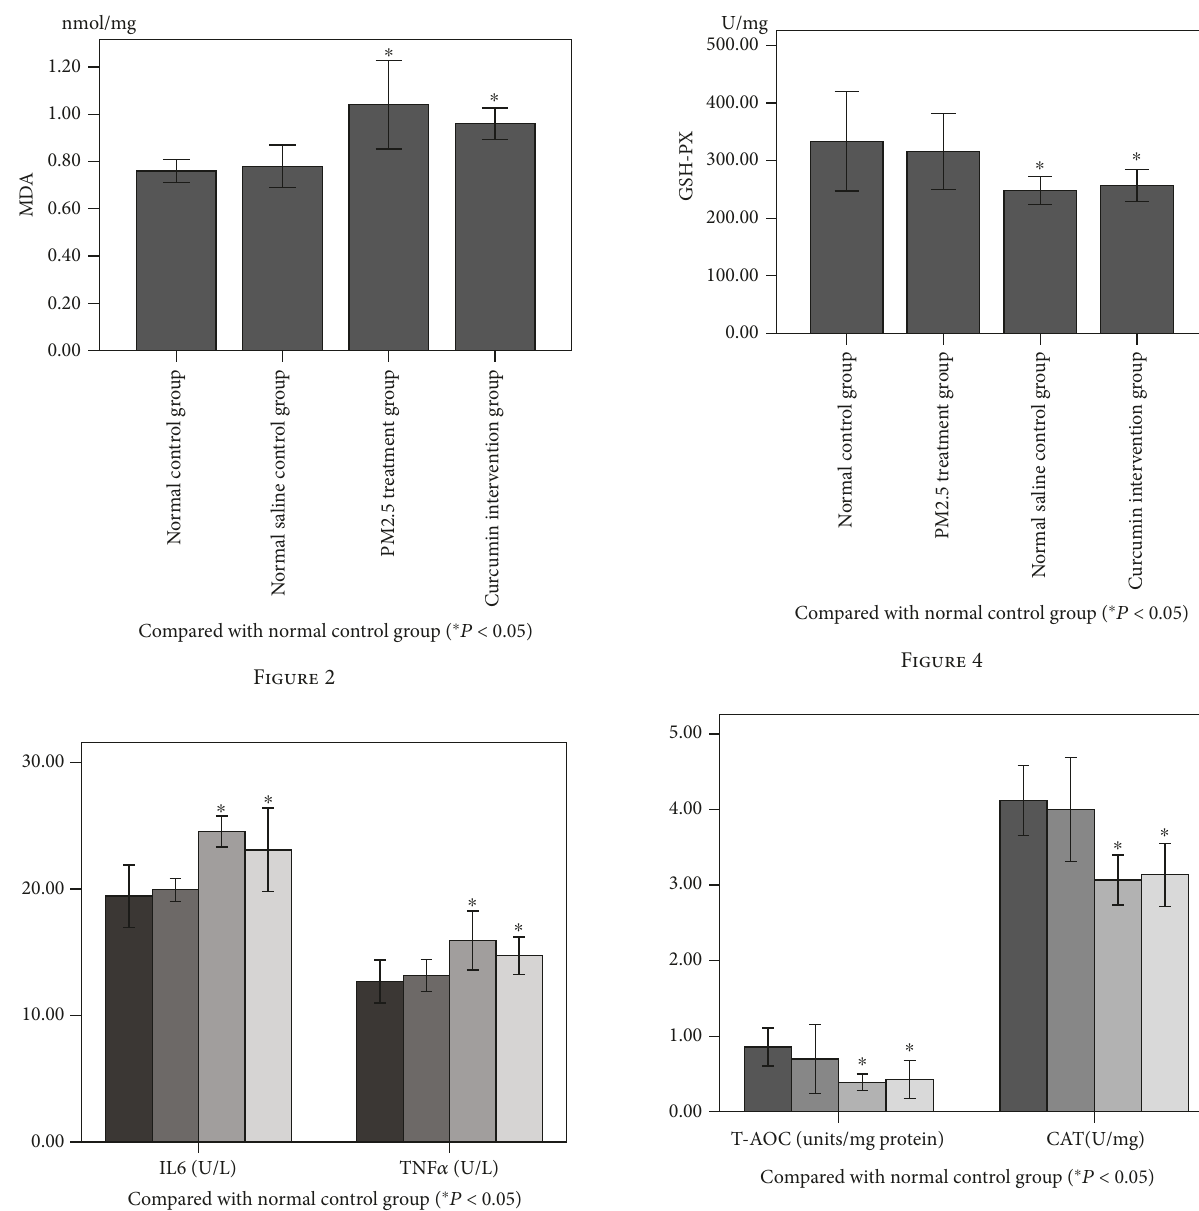
groupCompared with normal control group ( ⁎ P < 0.05) Normal control group Normal saline control group